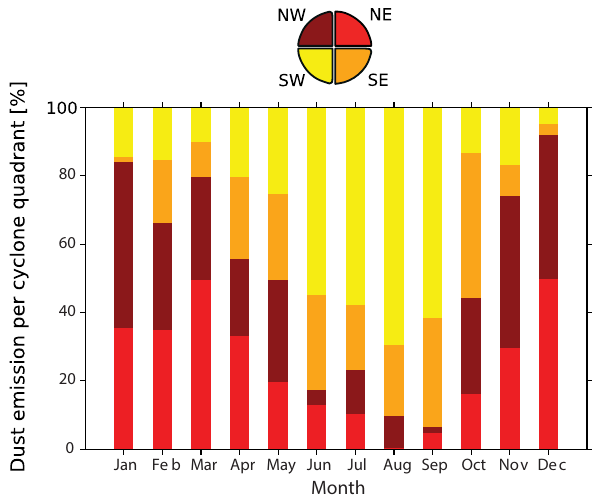
Figure 14. Monthly fraction of dust emission from the four quad- rants of long-lived and migrating cyclones averaged for the northern sub-domain (15 ◦ W–40 ◦ E and 20–40 ◦ N) and for